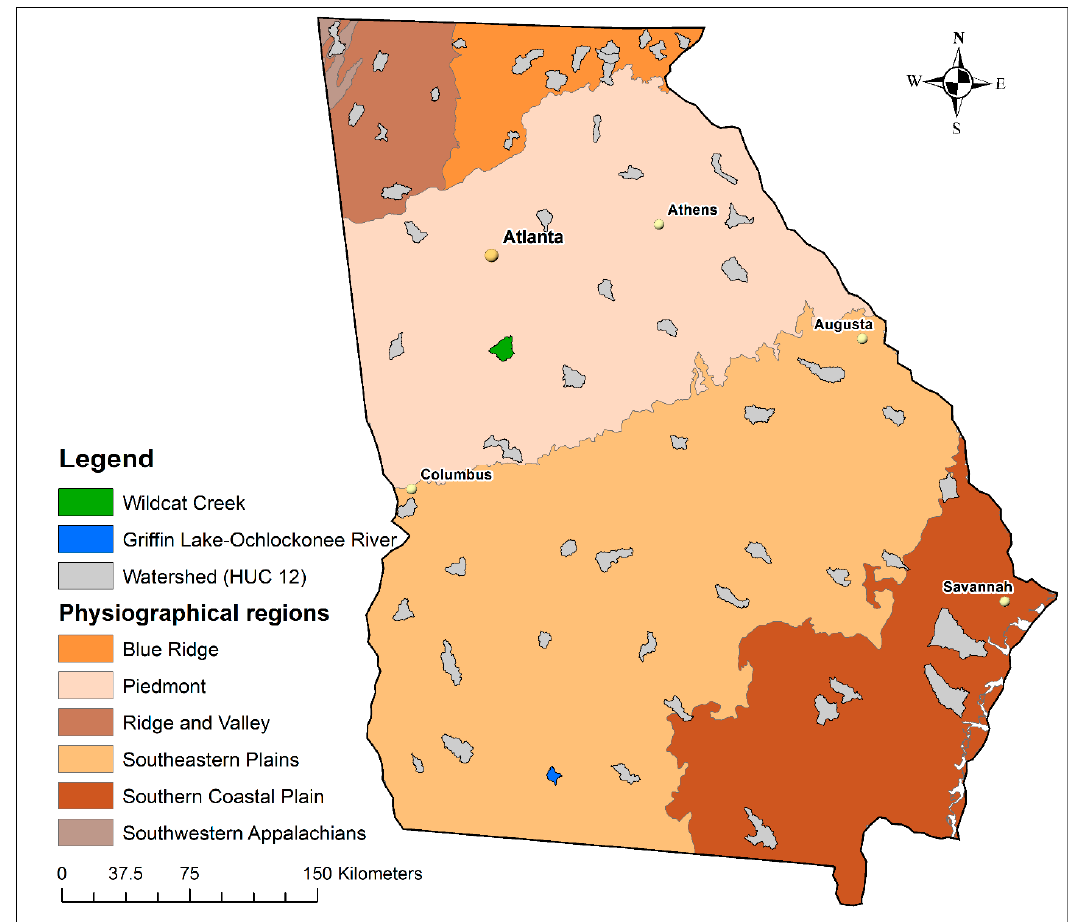
Figure 1. The full extent of the study area is a set of 57 watersheds within the state of Georgia in southern United States. Georgia can be divided in six physiographical regions, as displayed on the map. The Wildcat Creek and Griffin Lake–Ochlockonee River watersheds are highlighted on the map as they are mentioned in the text.